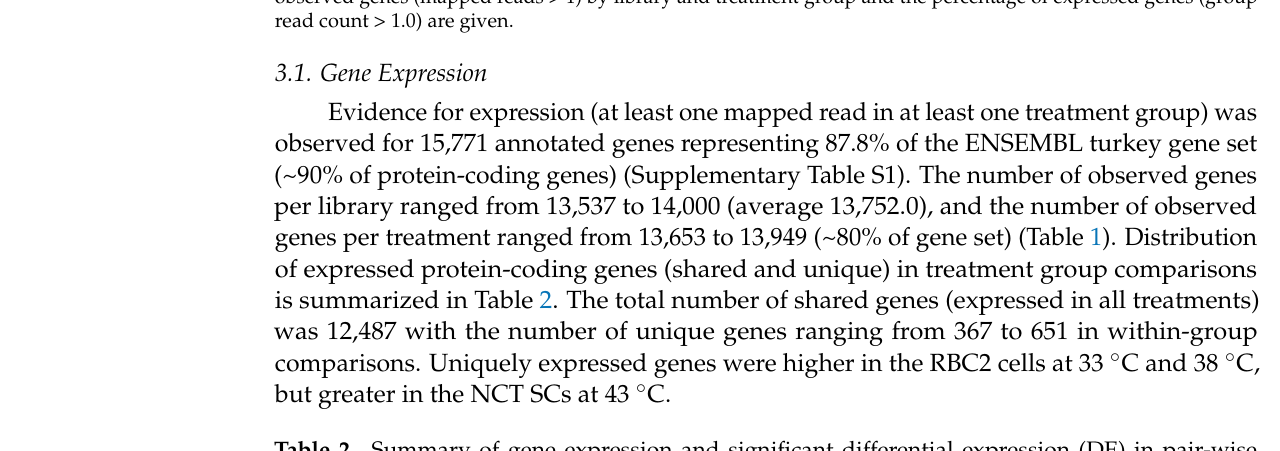
Table 2. Summary of gene expression and significant differential expression (DE) in pair-wise comparisons of differentiating